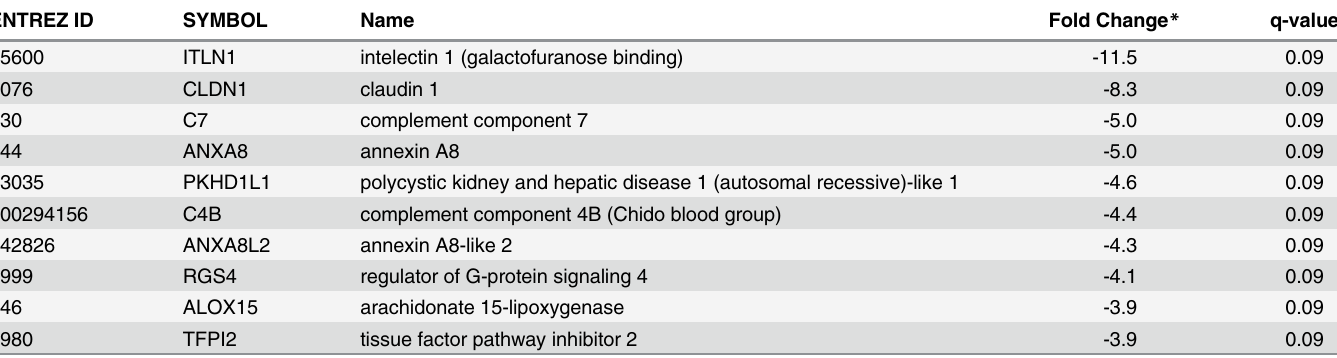
( * ) The fold change represents the number of times the average expression in one group is higher than the one in the other group. Positive values mean higher expression in subcutaneous compared to visceral tissues, while negative values represent higher expression in visceral compared to subcutaneous tissues. Genes are ranked by absolute fold